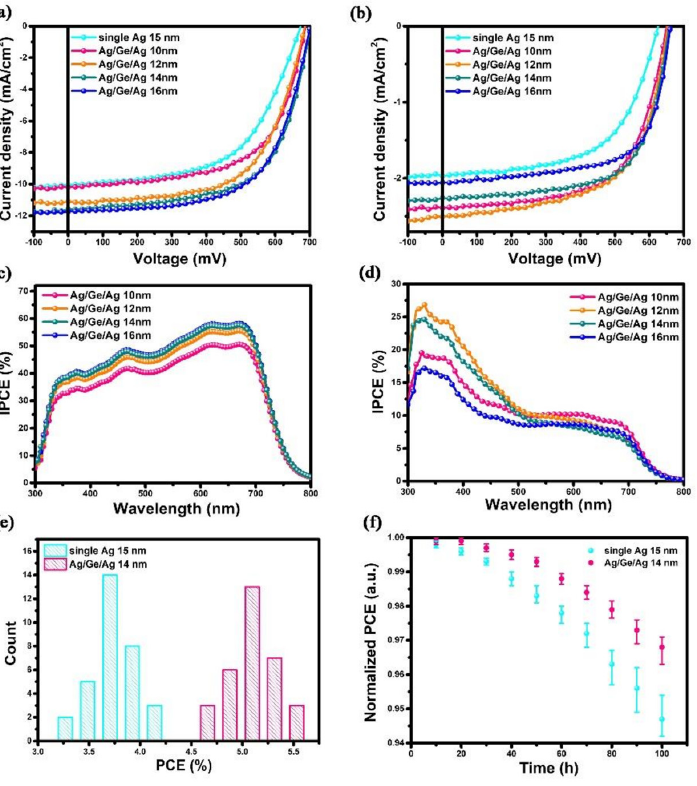
Figure 2. J − V characteristics of devices with a single Ag electrode (15 nm) and ITO/PEI/PTB7:PC 71 BM/MoO 3 /Ag (1 nm)/Ge (1 nm)/Ag (10, 12, 14, and 16 nm) depending on the thickness of the Ag capping layer when illuminated from ( a ) the ITO side and ( b ) the Ag/Ge/Ag side. IPCE spectra of devices measured from ( c ) the ITO side and ( d ) the Ag/Ge/Ag side. ( e ) The histograms for the performance of devices with a single Ag electrode and Ag/Ge/Ag electrode. ( f ) The normalized PCE of devices with a single Ag electrode and a Ag/Ge/Ag electrode. To further explore the relationship between the J SC value and electrode thickness, the IPCE values of the devices were measured when the light was illuminated from both the ITO side (Figure 2c) and the Ag/Ge/Ag electrode side (Figure 2d). As shown in Figure 2c, with the Ag capping layer increased from 10 nm to 16 nm, the IPCE was enhanced in the whole range from 300 nm to 800 nm. The enhancement was attributed to the improved conductivity of the continuous Ag film and the increased reflected light. As for the IPCE measured from the Ag/Ge/Ag electrode side, the value did not decrease linearly with the Ag thickness. The highest IPCE was not observed from the device with the Ag/Ge/Ag (10 nm) electrode, which achieved the highest transmittance value and allowed more incident light to the active layer. The highest IPCE value of 26.85% was observed at 330 nm from the device with the Ag/Ge/Ag (12 nm) electrode due to its better continuity compared to 10 nm